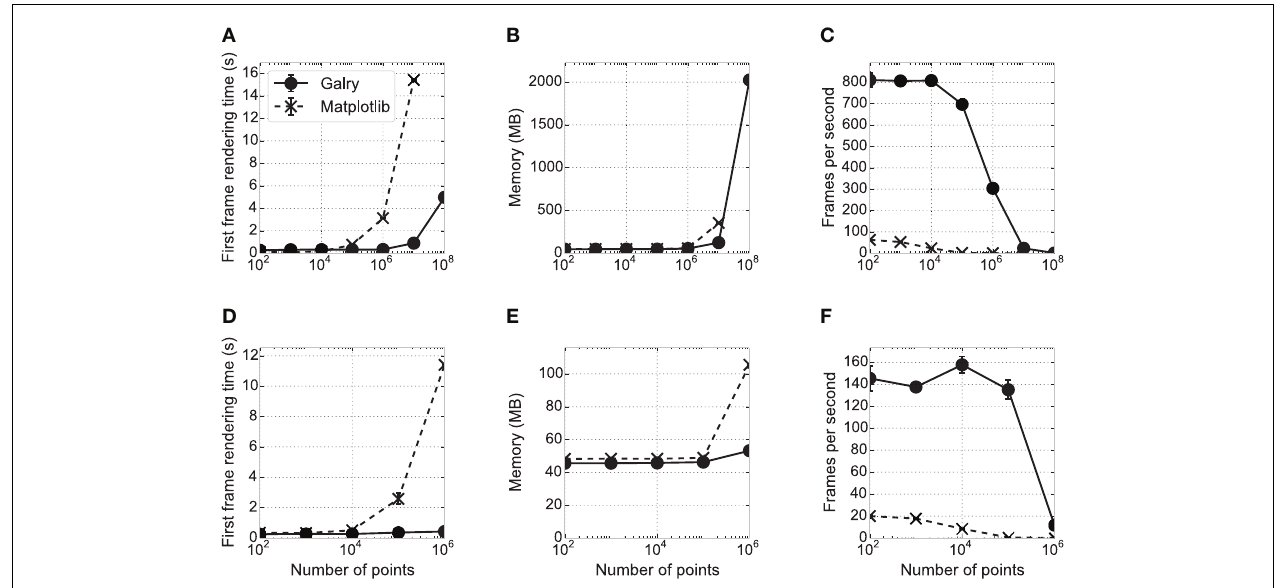
FIGURE 5 | Performance comparison between matplotlib and Galry. Ten line plots (white noise time-dependent signals) containing N points in total are rendered in matplotlib 1.3.0 with a Qt4Agg backend (dashed and crosses) and Galry 0.2.0 (solid and discs). All benchmarks are executed three times with different seeds (error bars sometimes imperceptible on the plots). The benchmarks are executed on two different PCs (see details below): PC1 (high-end desktop PC) in (A–C) , PC2 (low-end laptop) in (D–F) . (A,D) First frame rendering time as a function of the total number of points in the plots. (B,E) Average memory consumption over time of the Python interpreter rendering the plot. (C,F) Median number of frames per second with continuous scaling in the x direction (automatic zooming). Frame updates